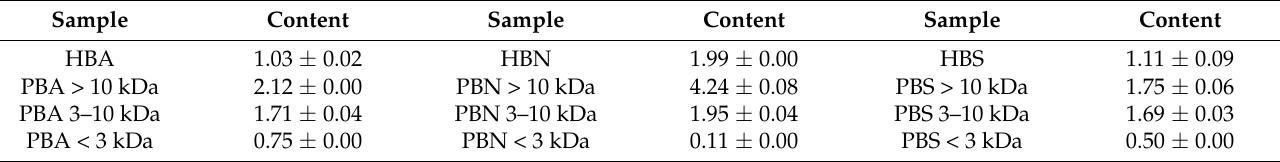
Table 1. Protein content (mg/mL) of hydrolysates and peptide fractions analyzed by the Lowry method.